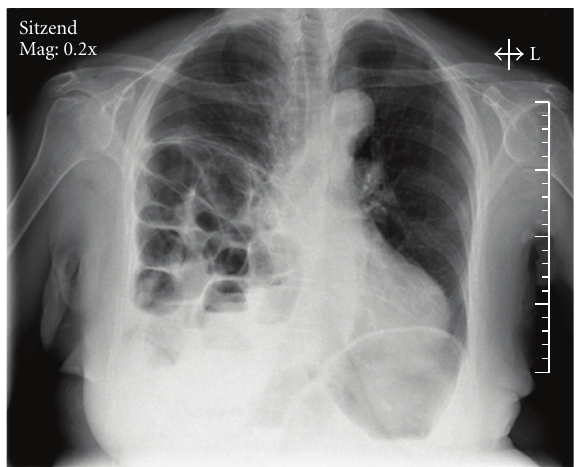
Figure 1: Chest radiograph shows bowel herniation into right hemithorax.